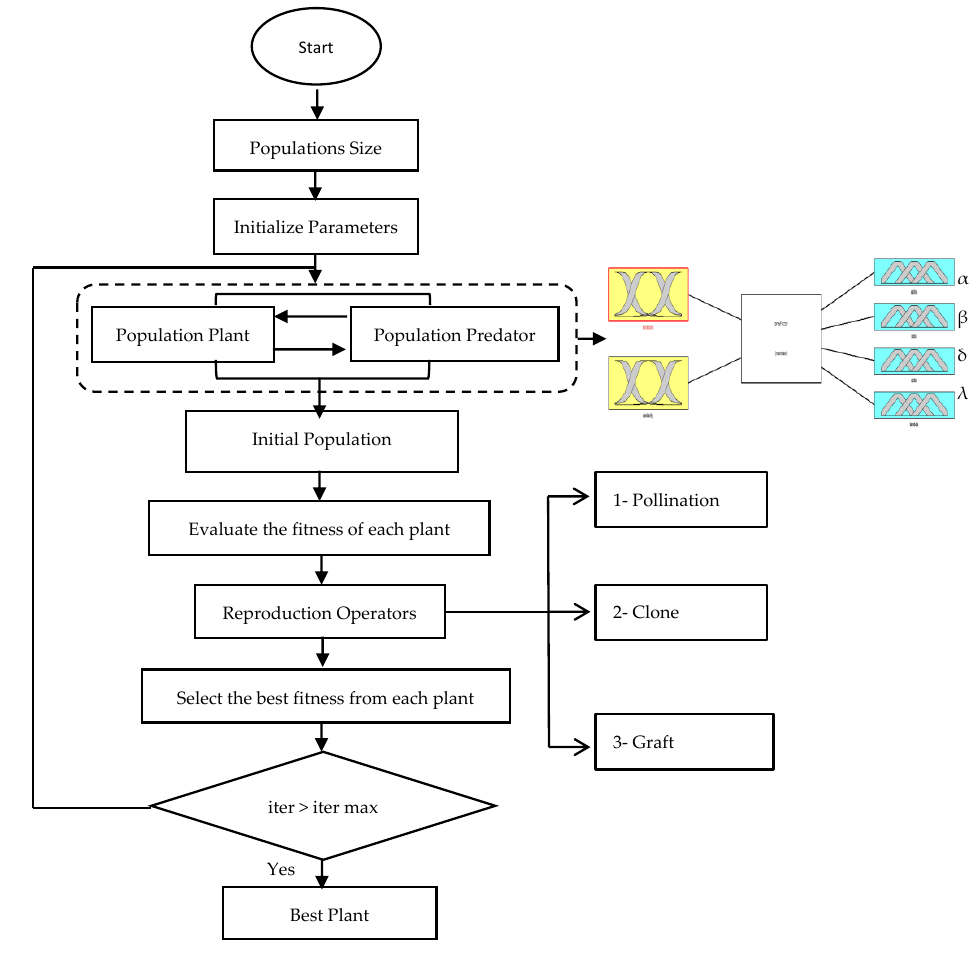
Figure 2. Flowchart with a fuzzy approach.